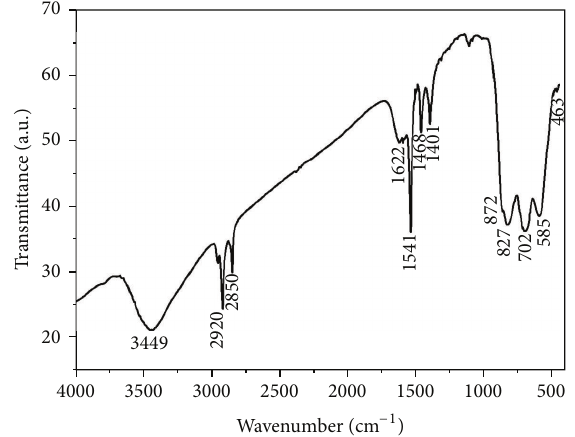
Figure 3: FT-IR spectra of ZnWO 4 formed at 180 ∘ C for